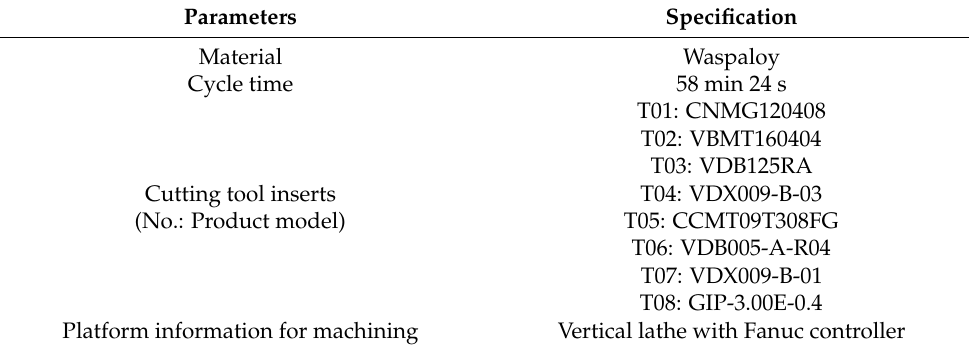
Table 1. The process